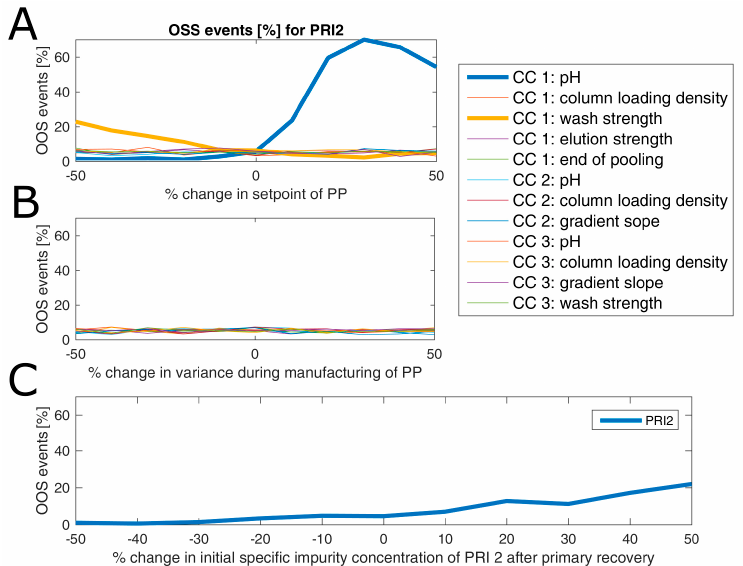
Figure 7. Estimated OOS event for product-related impurity 2 at drug substance as a function of change in set-point ( A ) and variance ( B ) of all PPs as well as a function of increased specific impurity concentration after primary recovery ( C ). Deviations in set-point of pH and salt concentration in wash of chromatography column 1 impact severely on OOS chance, which is not the case when variance in PPs increases by up to 50%. A change of specific product-related impurity 2 concentration at the primary recovery level will also increase OOS chances.